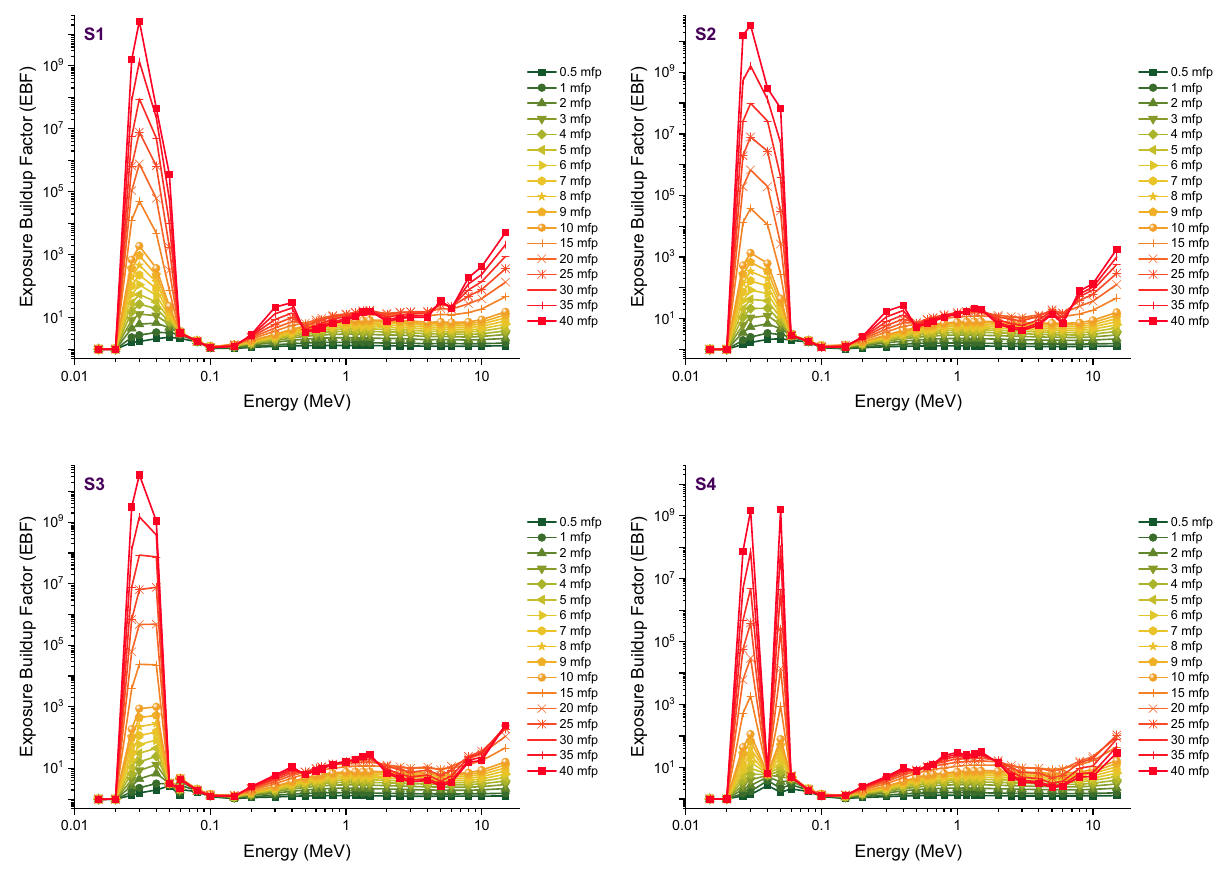
Figure 10: Variation in EBFs of investigated glasses at di ff erent mfp